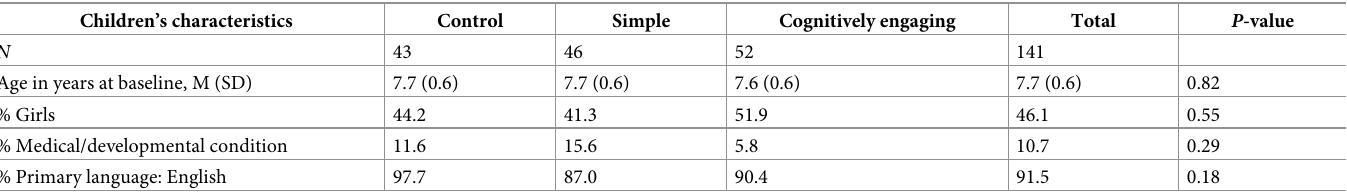
Table 1. Demographic characteristics of children included in the main analysis.